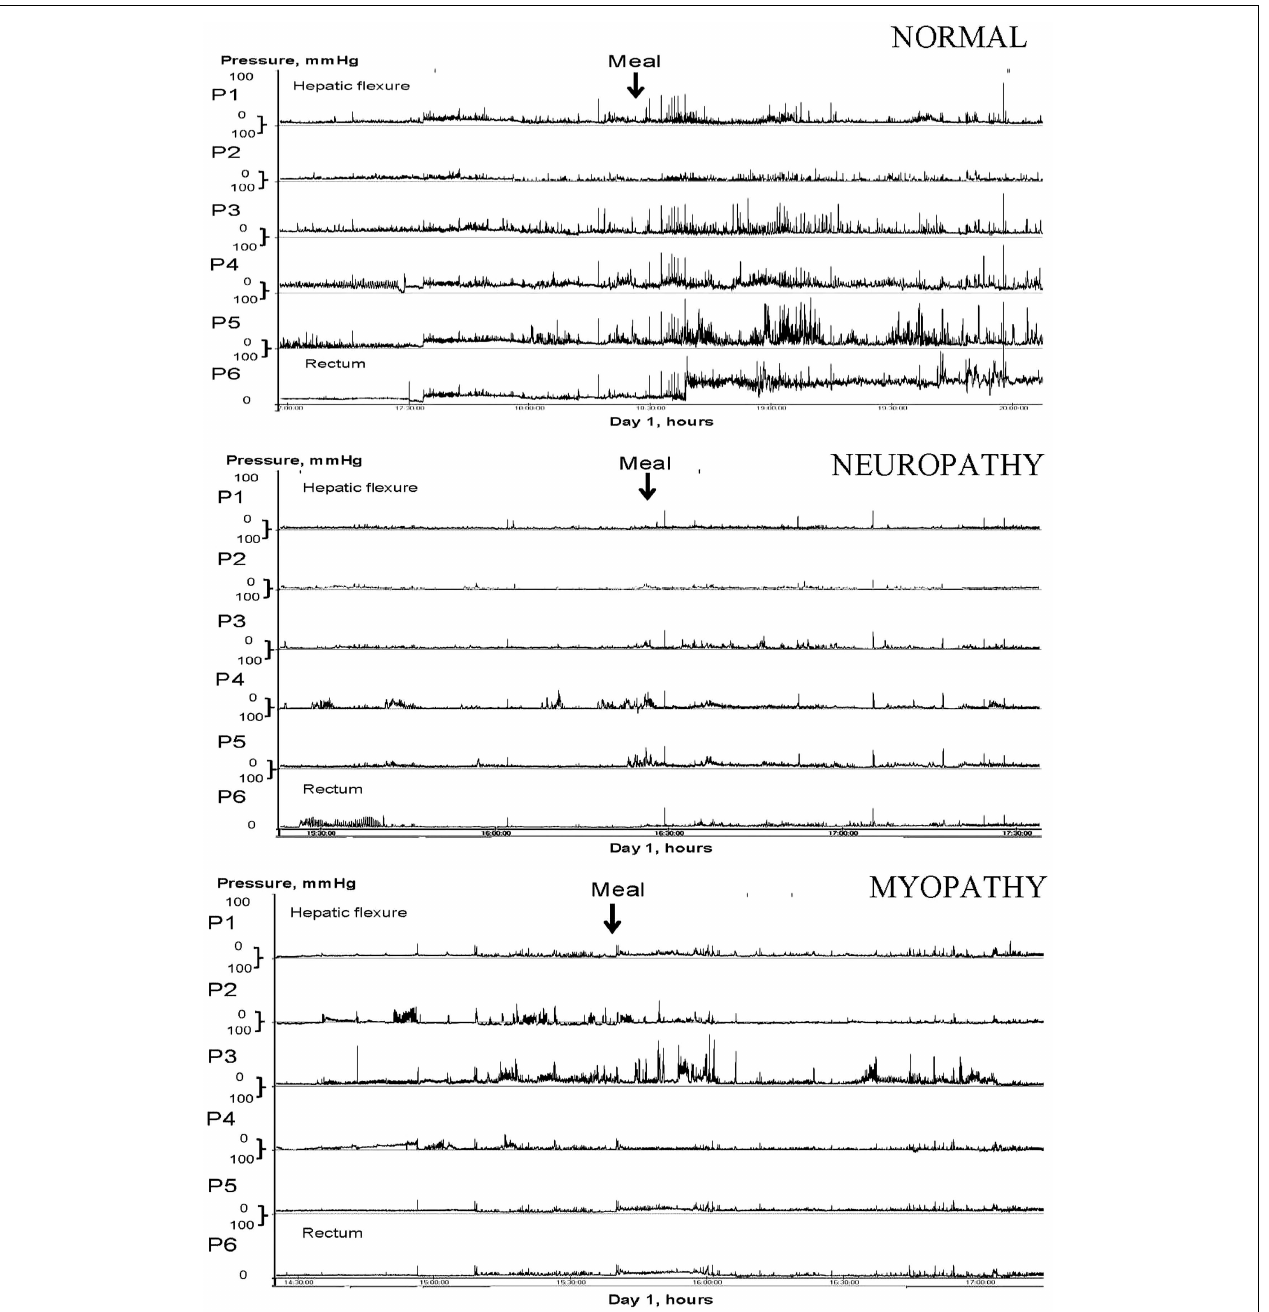
FIGURE 1 | Colonic manometry tracings in response to a meal. Traces for normal, neuropathy, and myopathy changes in slow-transit constipation are